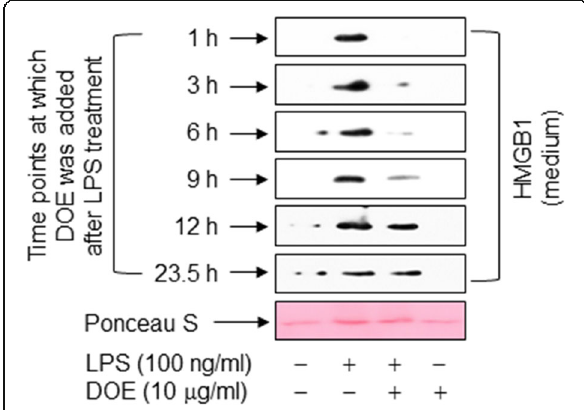
Fig. 3 Treatment with DOE after LPS exposure attenuates LPS-triggered release of HMGB1 in RAW 264.7 cells. Cells cultured for 24 h in serum-free medium were triggered by vehicle (DMSO) or LPS. DOE was added at the indicated time points after LPS treatment for 24 h. Equal volumes of conditioned medium were subjected to